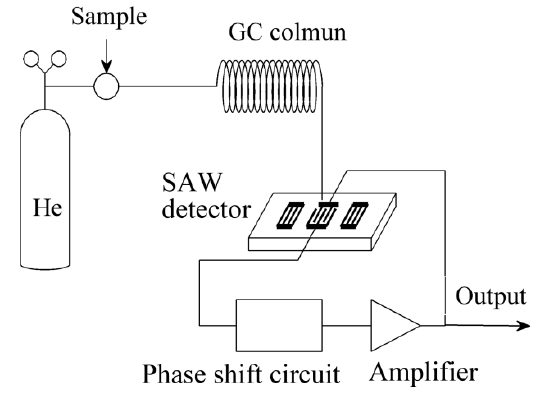
Figure 2. Schematic of the SAW-GC analyzer used in the